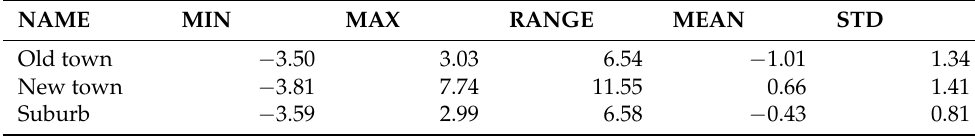
Table 6. Variation in LST in the three different regions of Hefei from 2000 to